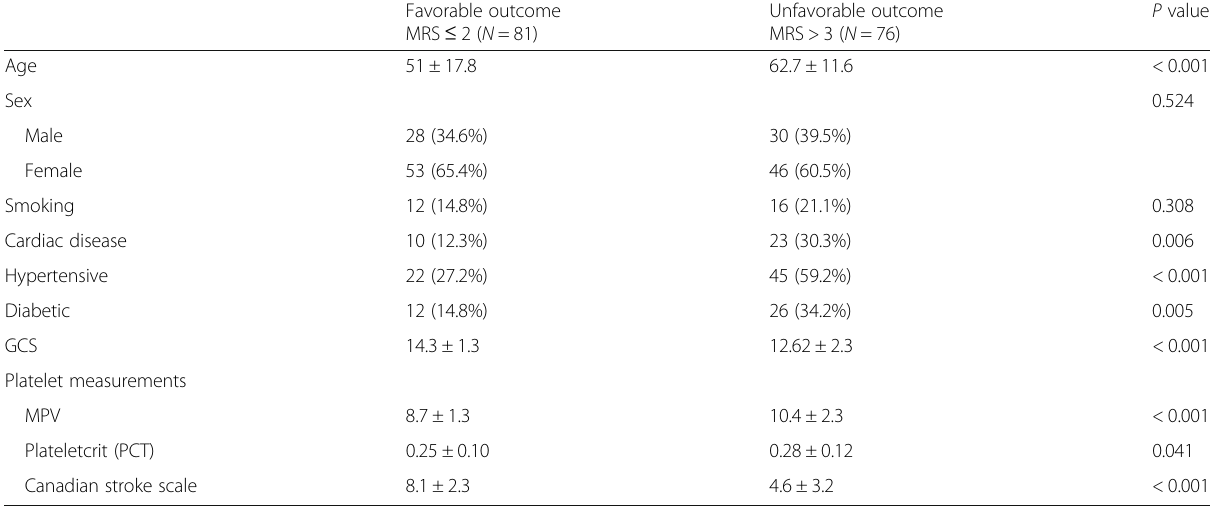
Table 2 Characteristic of patients in both favorable and unfavorable groups